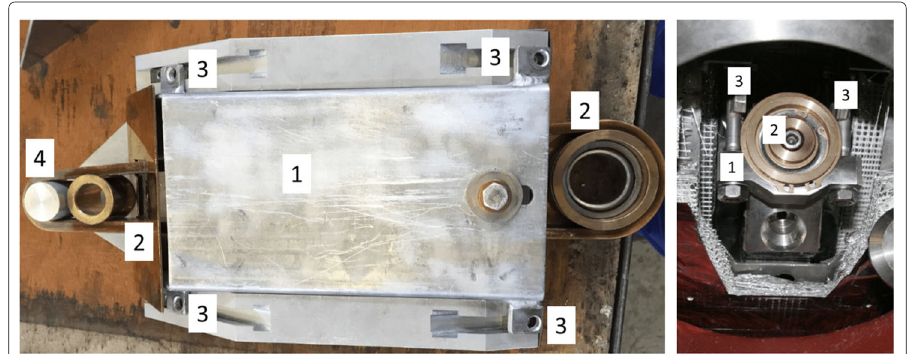
Fig. 19 Left: Original suspension of cold mass mounted to the transfer tool. 1: Radiation shield box, 2: G10 supporting loop, 3: Fastening ears, 4: Transfer pivot. Right: Steel bracket fastened to the lower end of the new suspension replacing the support by the G10 loop. 1: Bracket, 2: Support pivot, 3: Lower end of new suspension